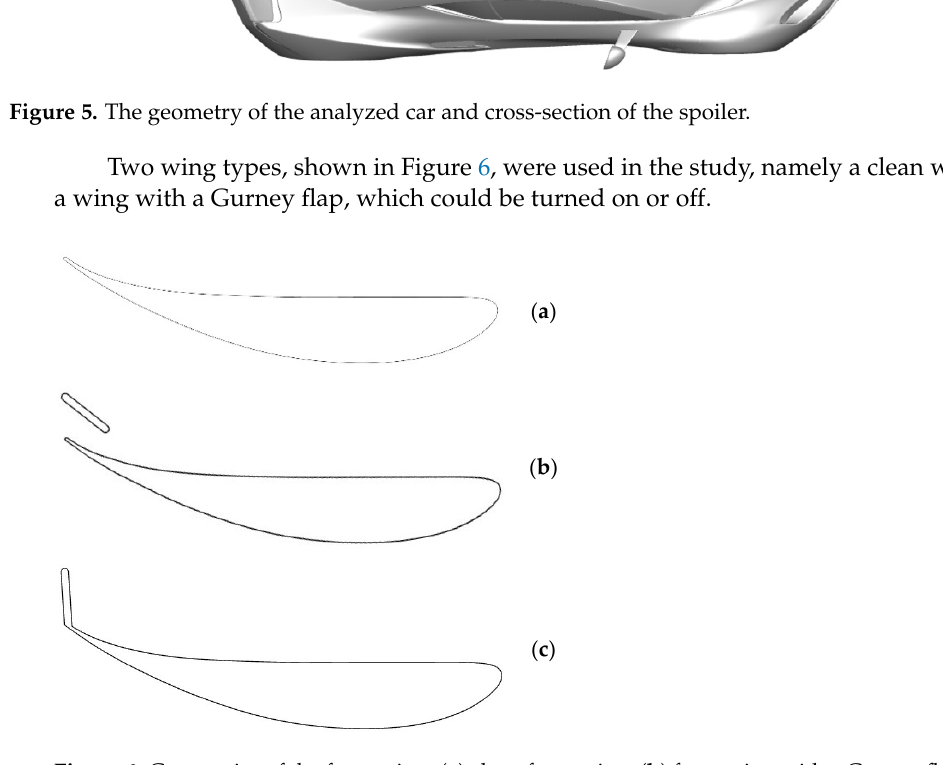
Figure 6. Geometries of the front wing: ( a ) clean front wing; ( b ) front wing with a Gurney flap turned off; ( c ) front wing with a Gurney flap turned on.